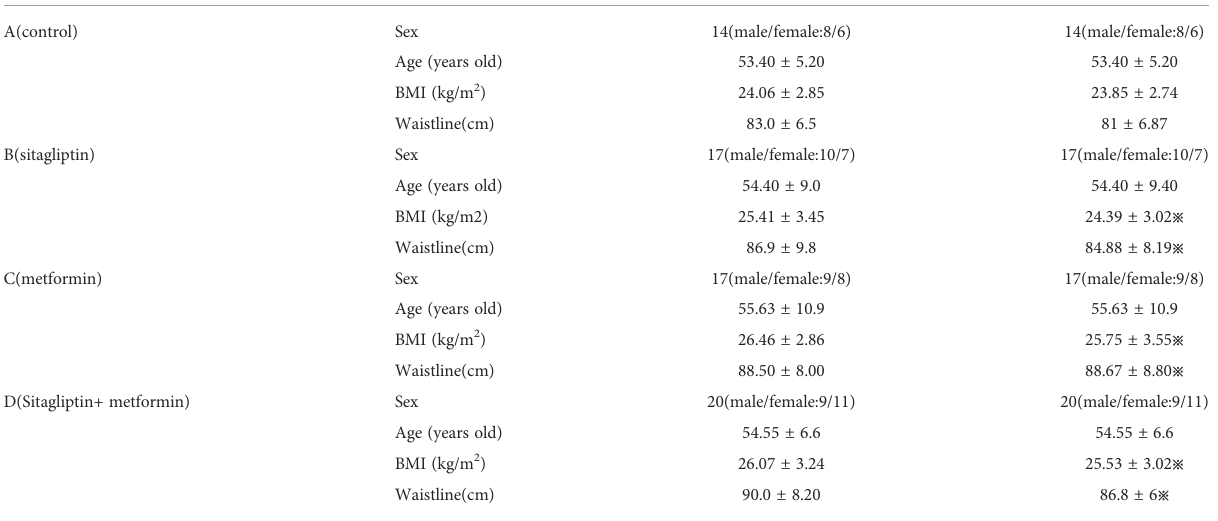
Self-pair comparison before and after treatment, ※ P<0.05. Data are number of patients or mean ± standard deviation. BMI, body mass